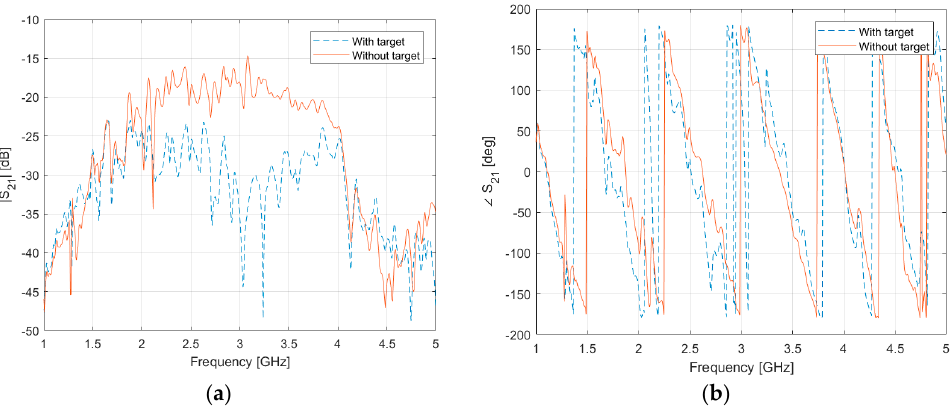
Figure 6. ( a ) Magnitude and ( b ) phase of the measured S 21 for a couple of facing antennas with and without the